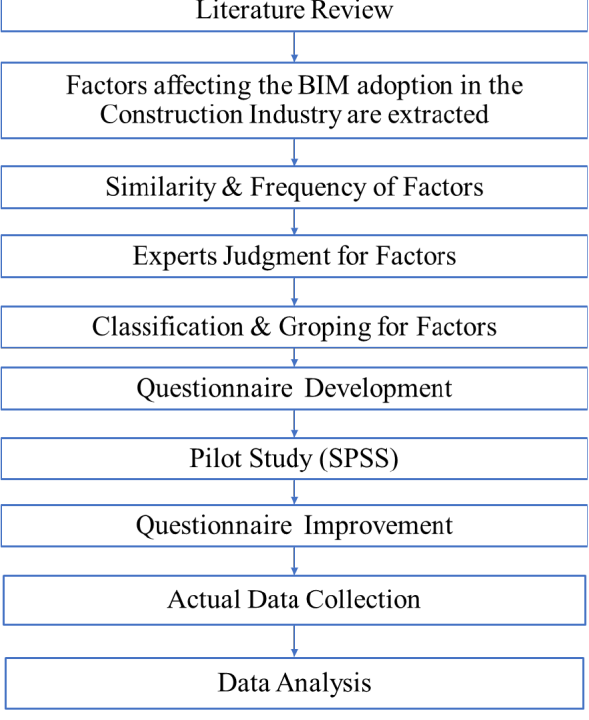
Figure 1. Research method.